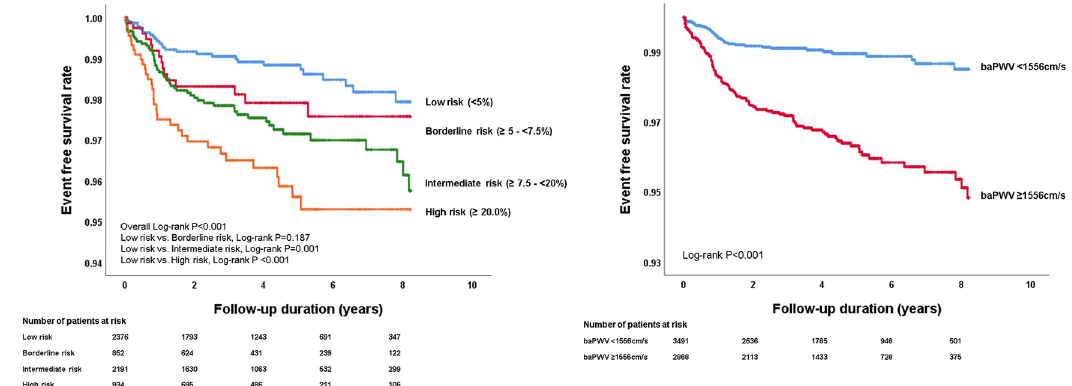
Fig 2. Event-free survival rates according to ACC/AHA ASCVD risk score (A) and baPWV (B). ACC/AHA ASCVD, American College of Cardiology/American Heart Association atherosclerotic cardiovascular disease; baPWV, brachial-ankle pulse wave velocity.